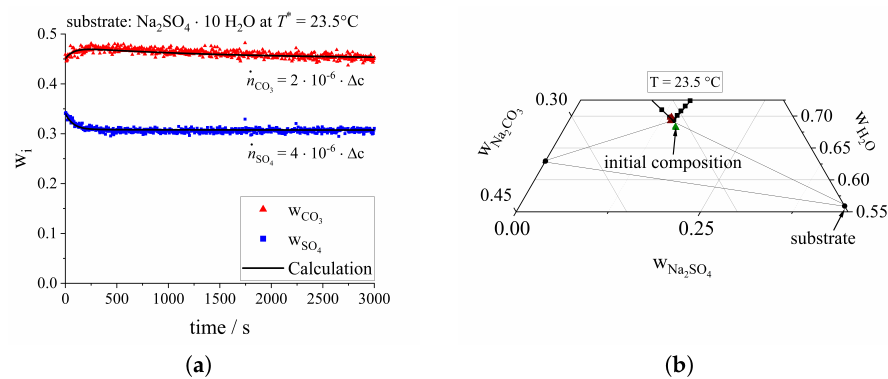
Figure 11. The substrate material (sodium sulfate decahydrate) desupersaturates at the beginning of the experiment. The foreign component increases in level and desupersaturates after reaching a maximum. The given equations were used to calculate the solid lines ( a ). In Diagram ( b ) the initial state (green triangle) and the final composition (brown triangle) are displayed in a ternary plot.